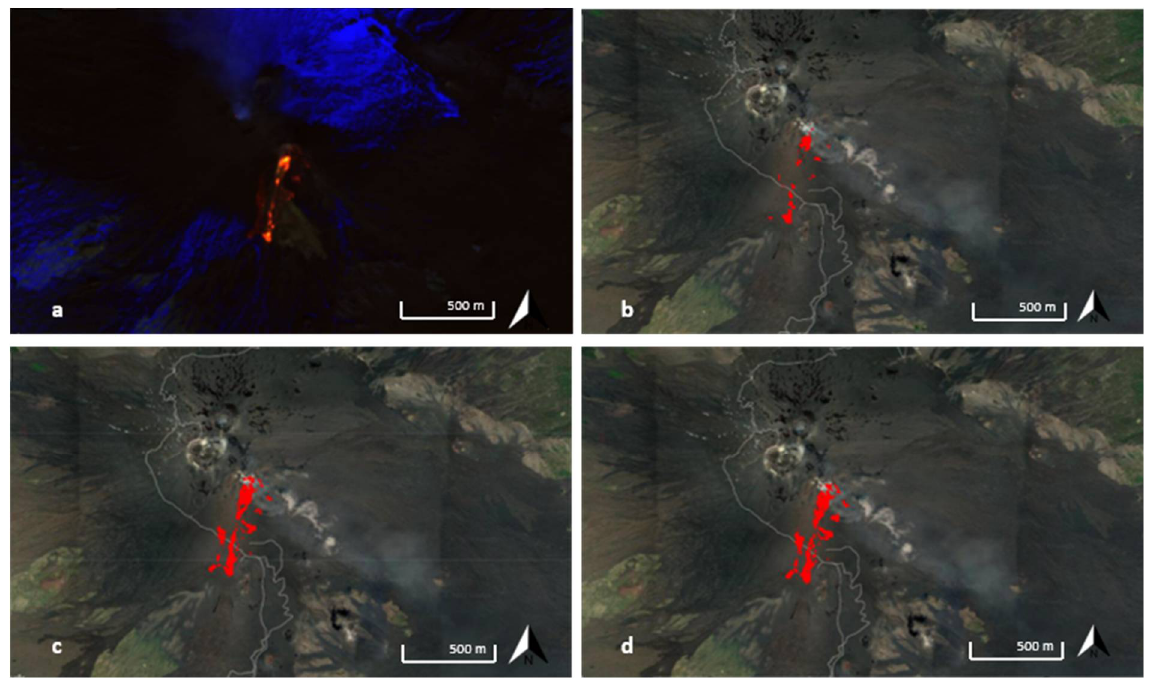
Figure 8. ( a ) False RGB (B12, B11, and B5) of Etna of 11 February 2022, ( b ) fixed-threshold output, ( c ) RF1 model output, and ( d ) RF2 model output.